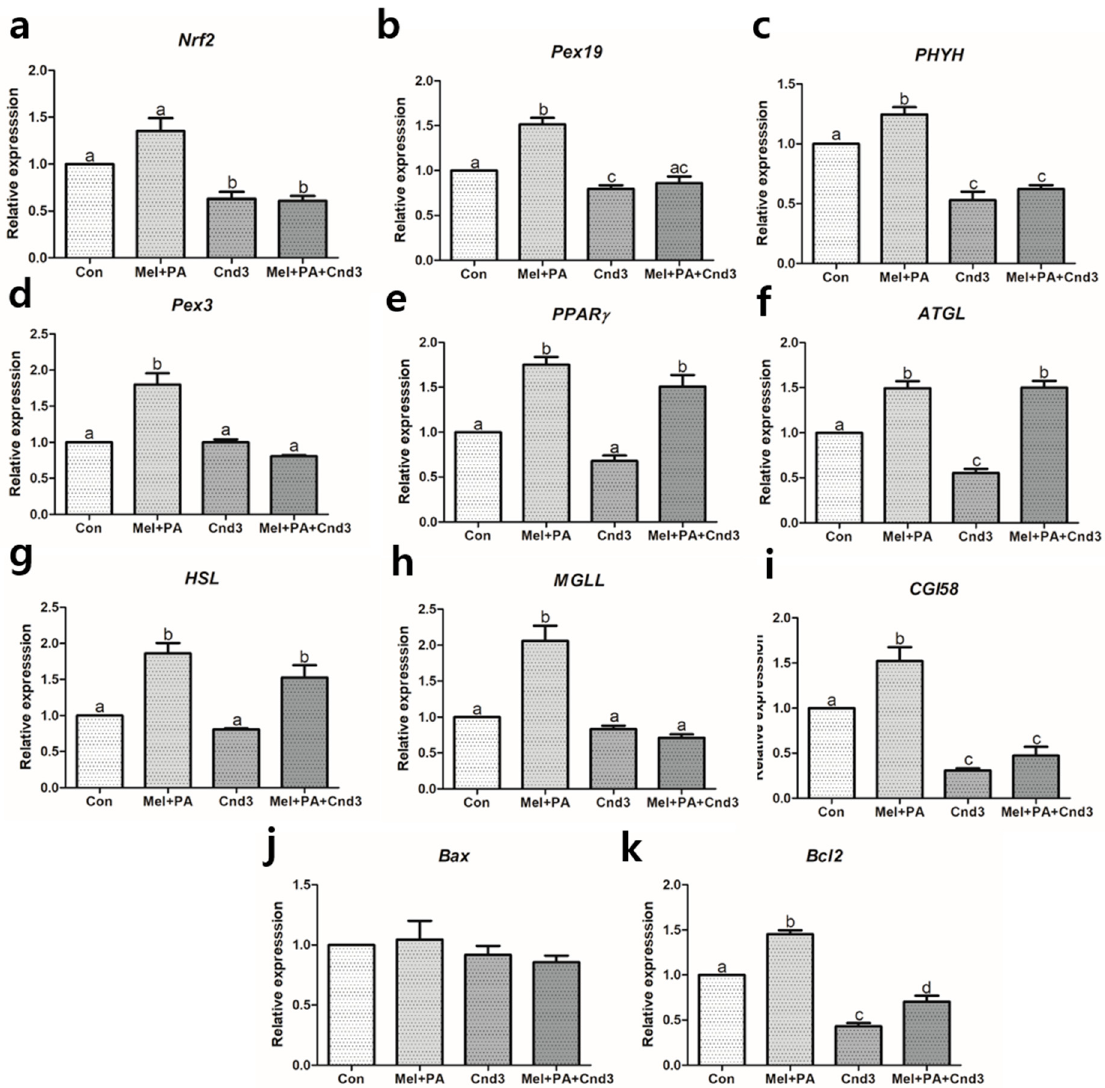
Figure 3. Gene expression evaluations of melatonin/PA treatment and Cnd3-injection on porcine blastocysts. The gene expressions of ( a ) Nrf2, the main factor in the Nrf2 signaling pathway, ( b – e ) factors that are related to peroxisomal activities, ( f – i ) lipid metabolism, and ( j , k ) apoptosis in the embryos were analyzed within the four groups. More than 50 blastocysts in each experimental group from six biological replications were used and real-time PCR was performed three times technically. Within the same mRNA, bars with different alphabetical letters are significantly different among the groups ( p < 0.05). Con, control; mel, melatonin, PA, phytanic acid; Cnd3, siRNA candidate 3.